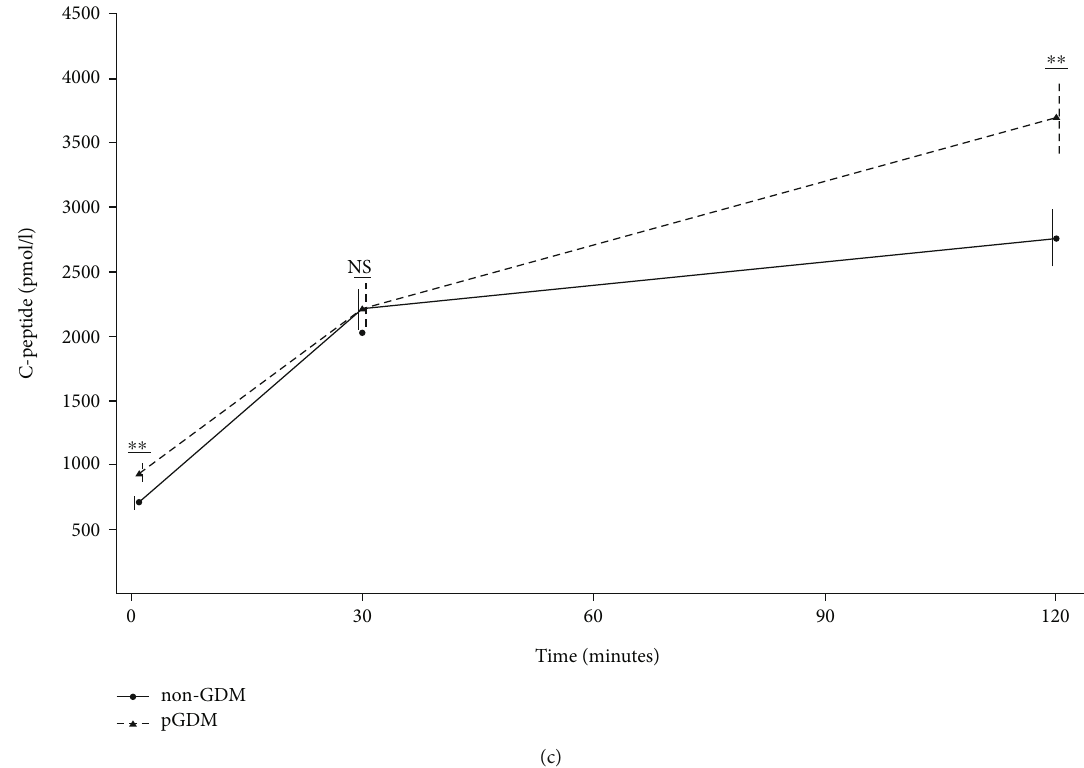
Figure 2: Concentrations of (a) plasma glucose, (b) serum insulin, and (c) serum C-peptide during an oral glucose tolerance test (OGTT) of women with previous gestational diabetes mellitus (pGDM) but without known type 2 diabetes mellitus ( n = 112 ) and controls (non-GDM, n = 70 ). ∗ p < 0 : 05 and ∗∗ p < 0 : 01 . Presented as the mean ± 95 % confidence interval